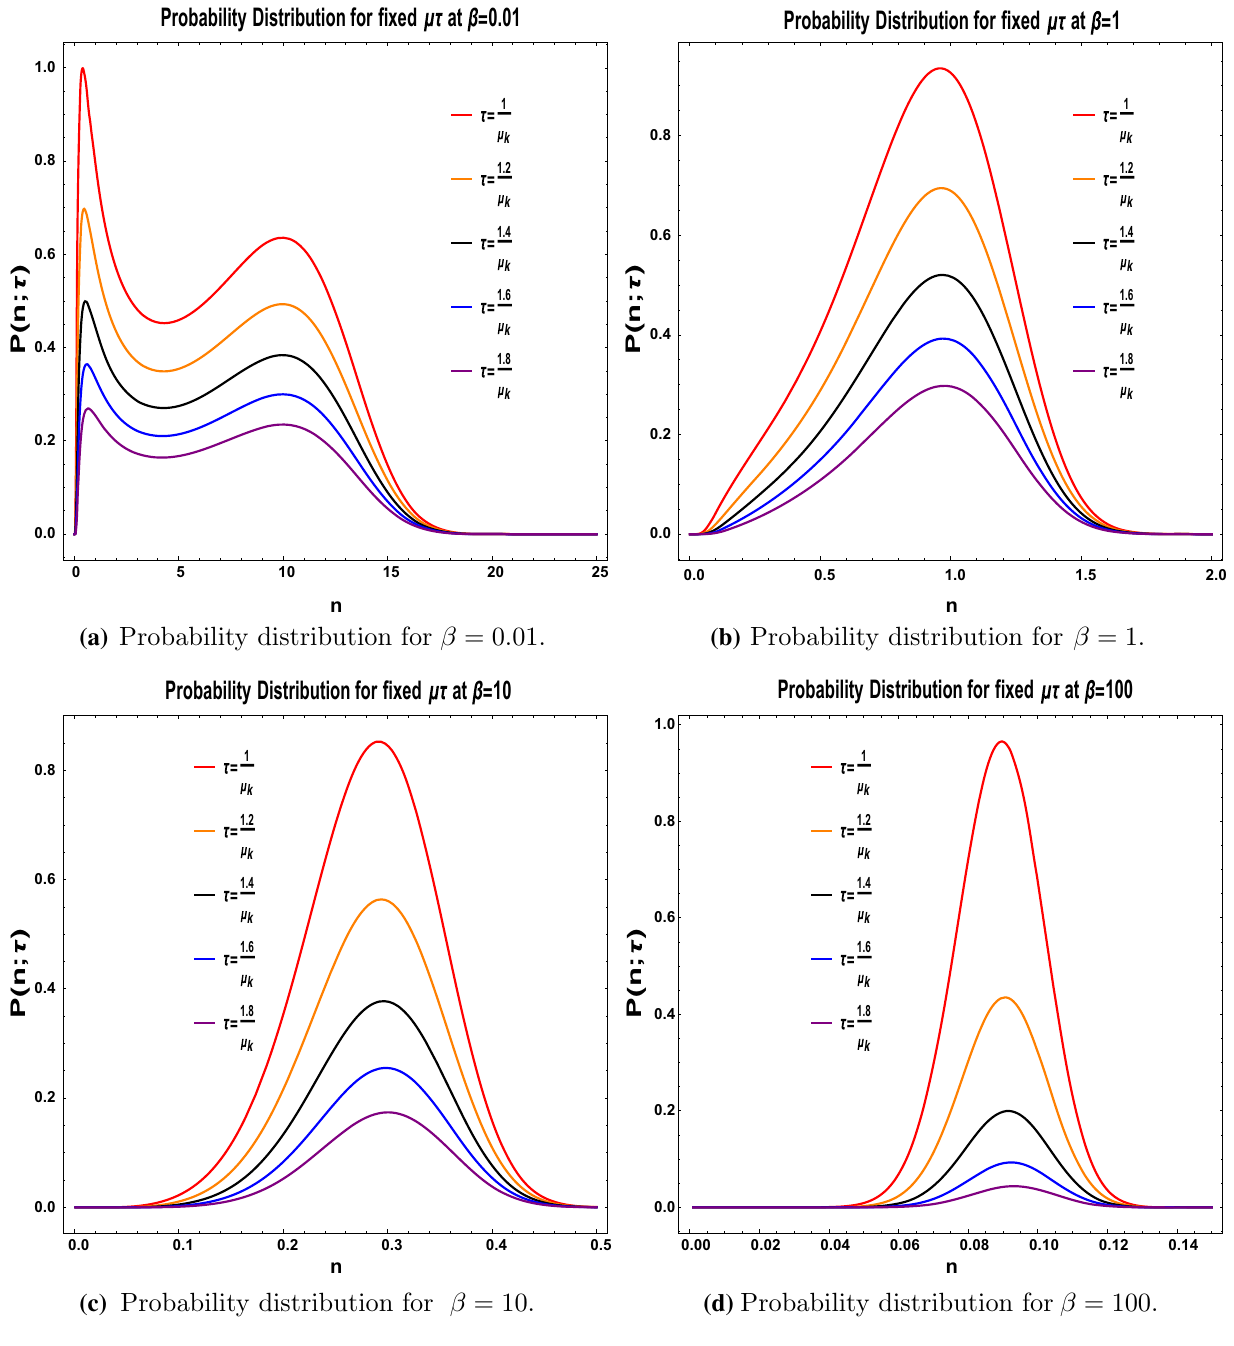
Fig. 58 Evolution of the probability density function for generalized prescription with respect to the occupation number per mode n , for a fixed time and β